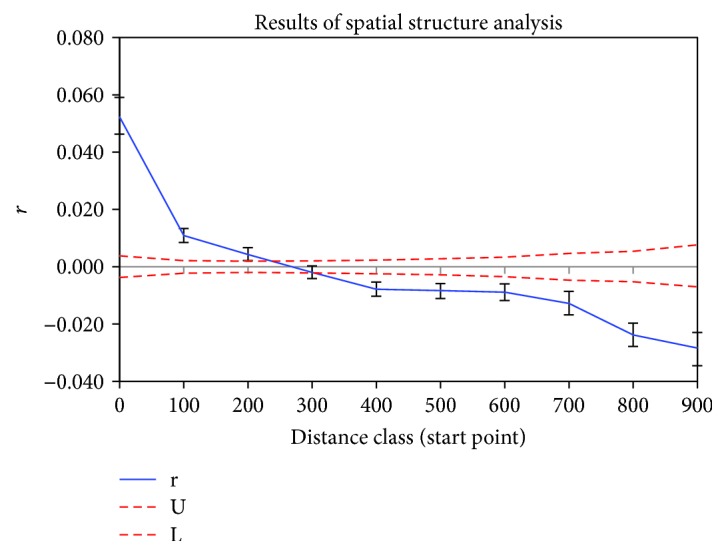
Results of spatial structure analysis. r: solid lines represent spatial autocorrelation coefficients; U and L: dashed lines represent 95% confidence interval.